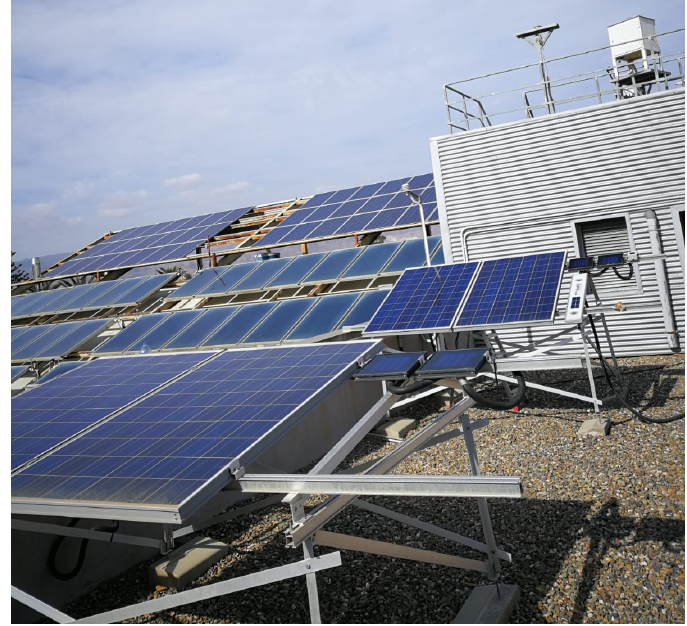
Figure 1. Experimental facility at the Universidad de Almería.